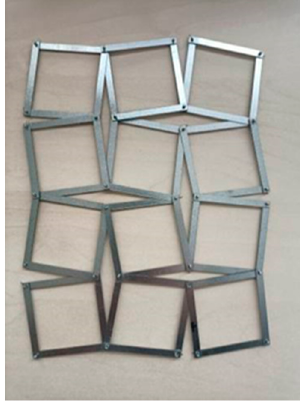
Figure 11. A structure made of metal bars connected to each other by axes of rotation at different stages of folding; pseudo-construction of rotating squares in the closed position ( a ) and in the open position ( b ) and folded state ( c ).